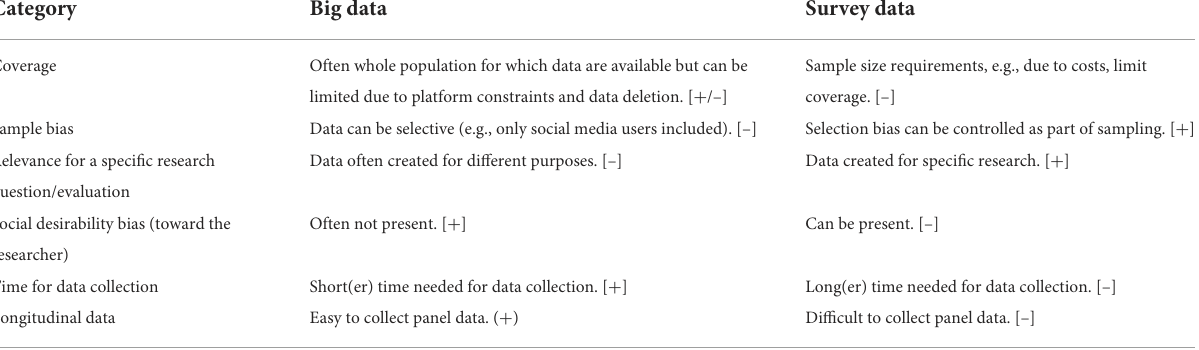
TABLE 1 Comparison of big data and survey data used in development research and evaluation. Category Big data Survey data